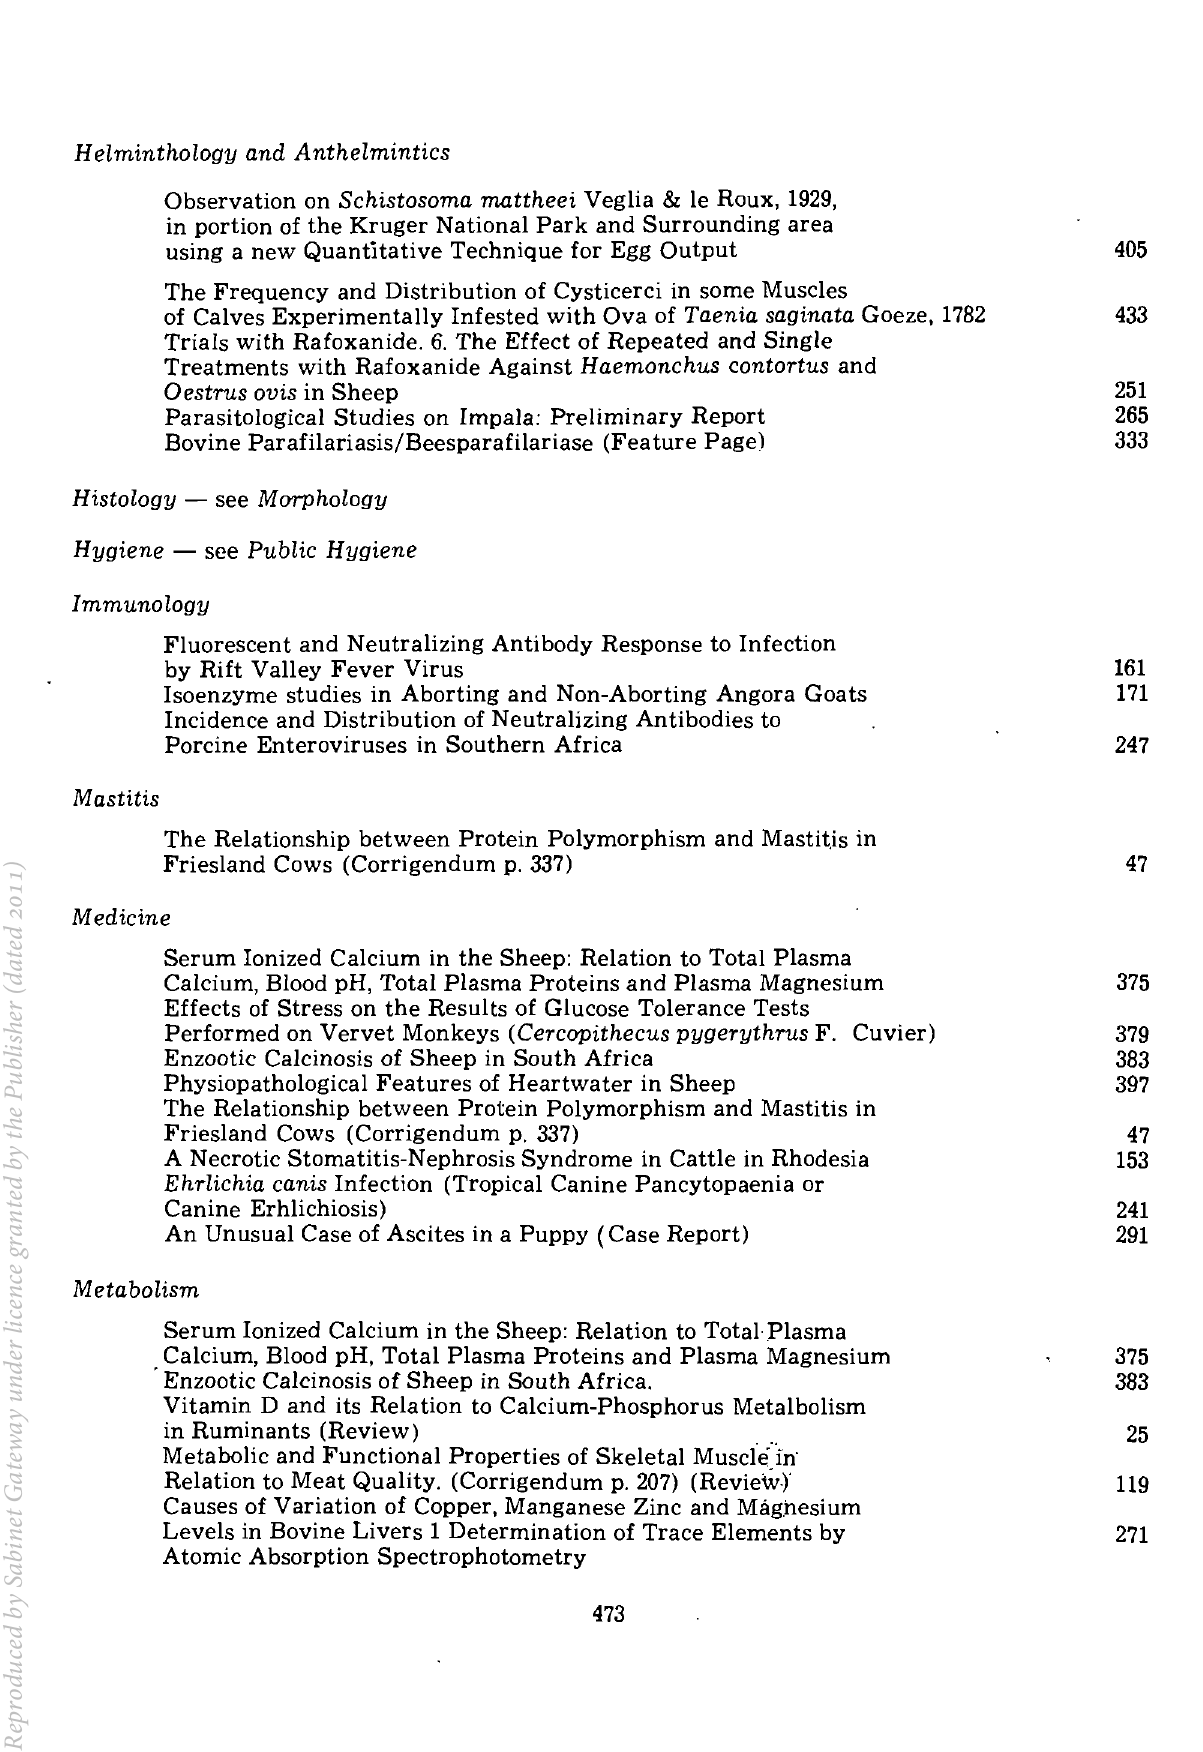
Serum Ionized Calcium in the Sheep: Relation to Total Plasma Calcium, Blood pH, Total Plasma Proteins and Plasma Magnesium Effects of Stress on the Results of Glucose Tolerance Tests Performed on Vervet Monkeys (Cercopithecus pygerythrus F. Cuvier) Enzootic Calcinosis of Sheep in South Africa Physiopathological Features of Heartwater in Sheep The Relationship between Protein Polymorphism and Mastitis in Friesland Cows (Corrigendum p. 337) A Necrotic Stomatitis-Nephrosis Syndrome in Cattle in Rhodesia Ehrlichia canis Infection (Tropical Canine Pancytopaenia or Canine Erhlichiosis) An Unusual Case of Ascites in a Puppy (Case Report)